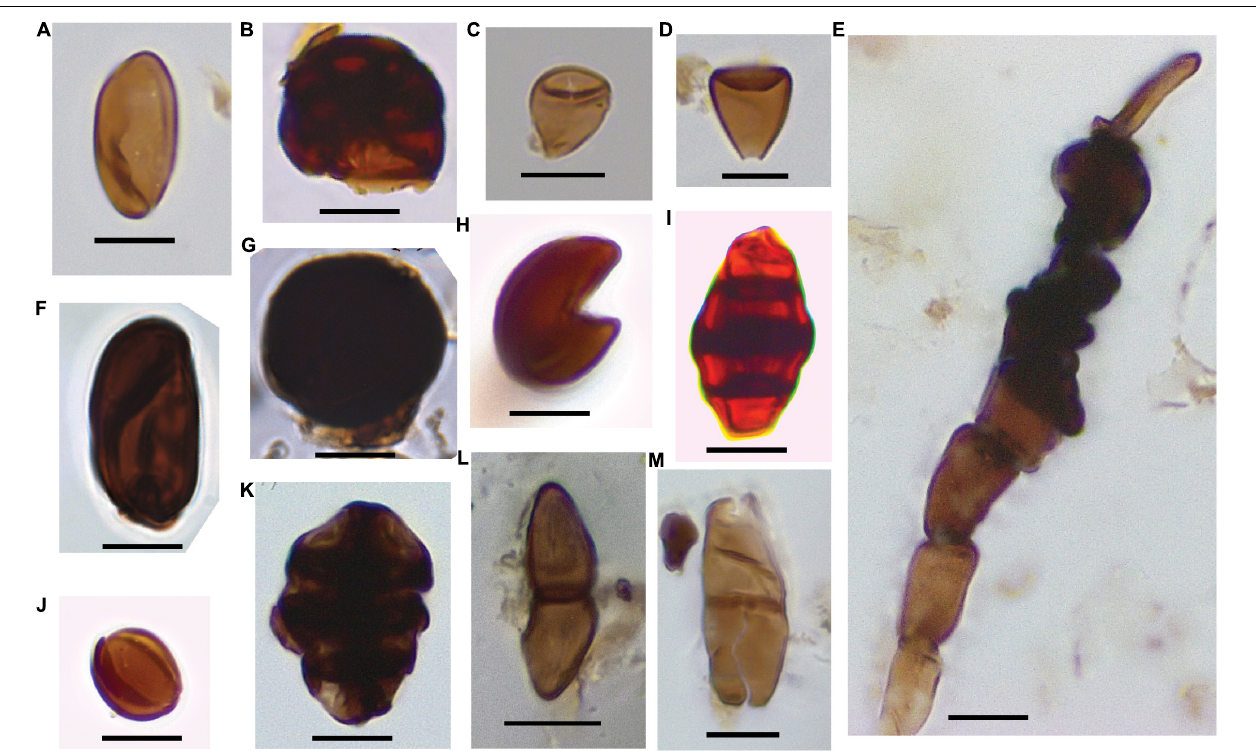
FIGURE 5 | Other fungal spores identified in Thailand and Slovakia. Each photograph indicates: identification if any, the sample number, morphotype number (OPaL #), and England Finder coordinates (EF). (A) cf. Rosellinia , sample 454, OPaL 40, EF: Z29; (B) cf. Berkleasmium, sample 456, OPaL 223, EF: H27; (C) cf. Catenularia sp., sample 454, OPaL 93, EF: F34-1; (D) Catenularia aff. catenulata , sample 454, OPaL 281, EF: Y31-3; (E) Phaeosclera -type, sample 453, OPaL 95, Z48; (F) cf. Ascobolaceae, sample 454, OPaL 39, EF: O26-4; (G) cf. Monotosporella, sample 8, OPaL 18, J24; (H) cf. Arthrinium , sample 455, OPaL 36, EF: